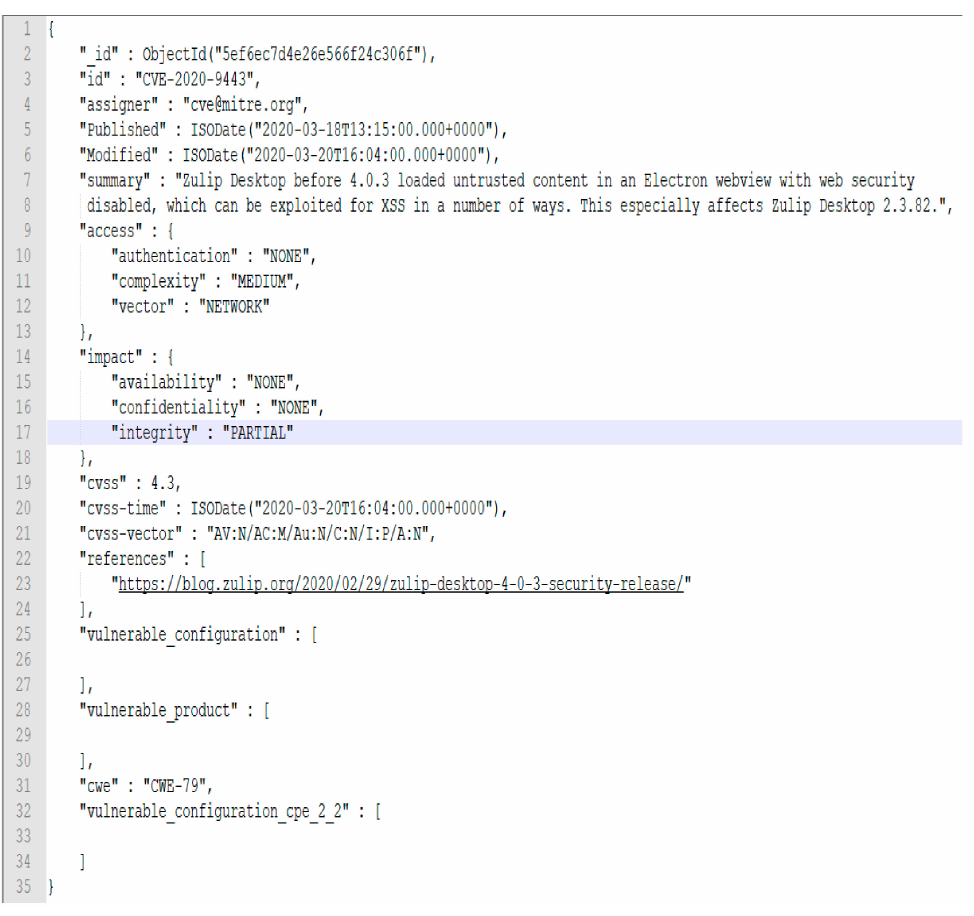
Figure 1. Features of the “cve” table.